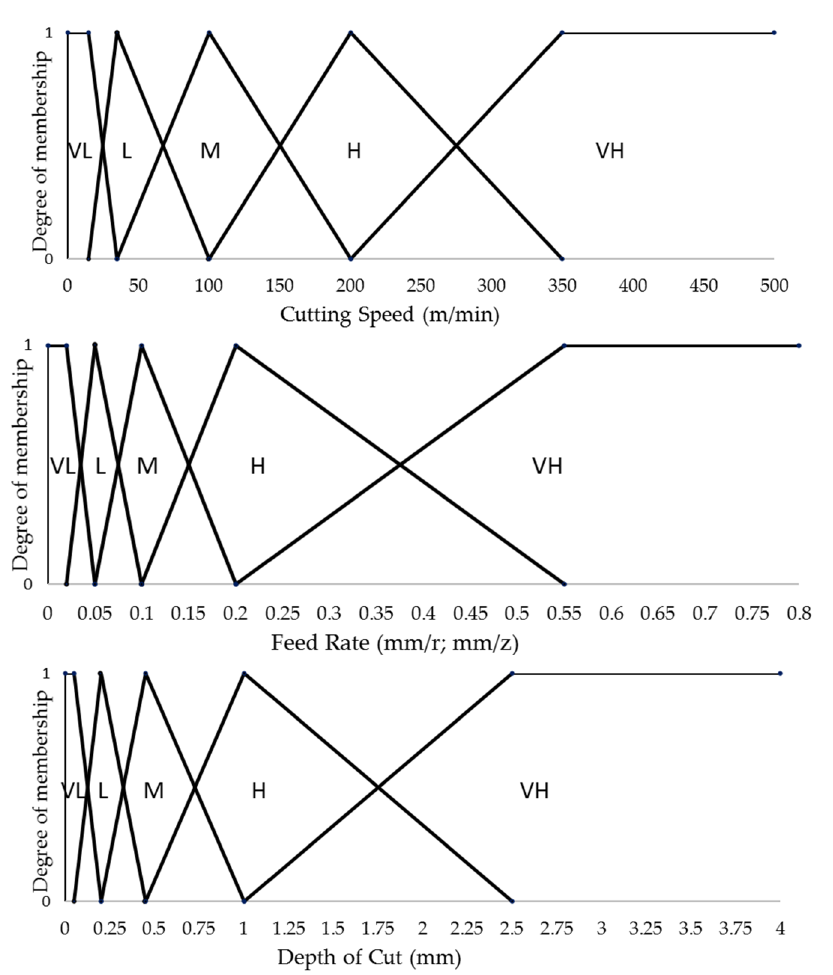
Figure 2. Fuzzy sets for the numeric control parameters of machining.